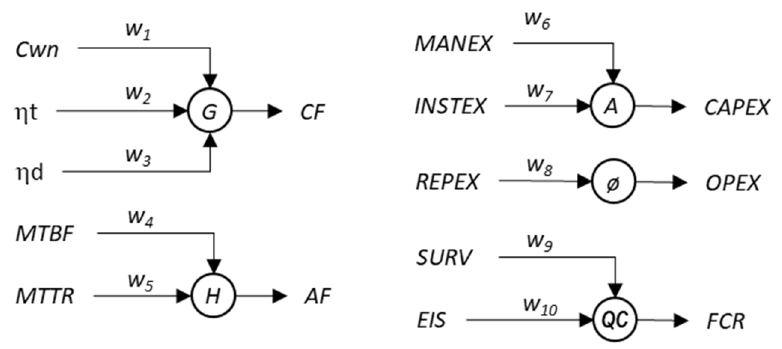
Figure 10. Aggregation of MOP.